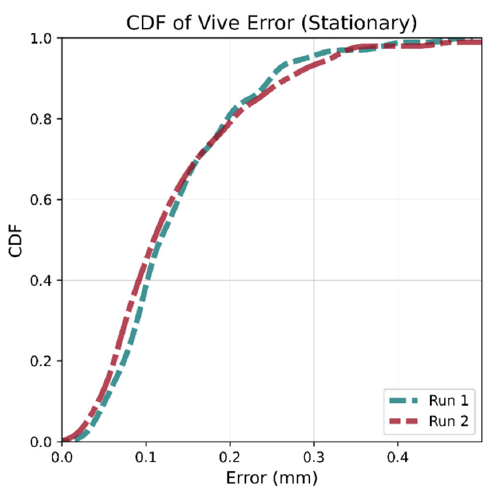
Figure 5. CDF for Vive jitter at different locations and orientations. The two runs are very similar indicating that there is no spatial dependence.